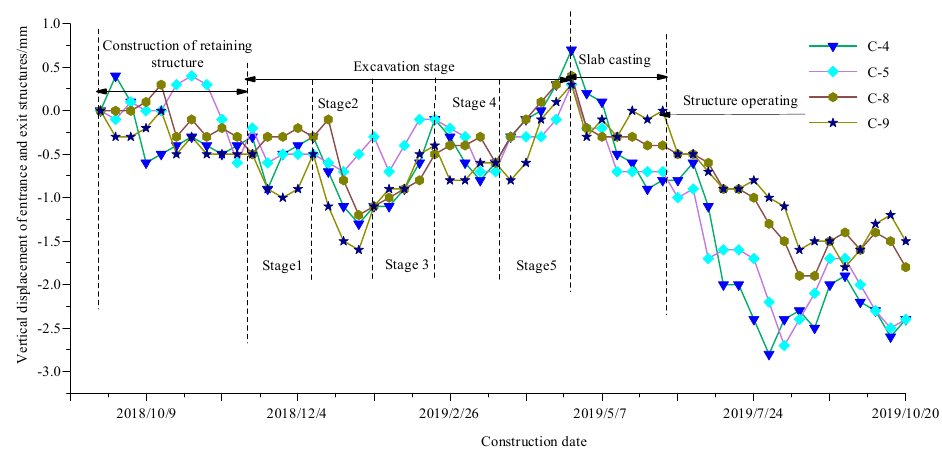
Figure 11. Vertical displacement time − history curve of entrance and exit structures. The measured data of CH-1, CH-2, CH-3 and CH-4 at the horizontal deformation monitoring points at the entrance and exit are selected for analysis, as shown in Figure 12. The horizontal displacement deformation trend of the entrance and exit gradually increases, which is consistent with the horizontal displacement deformation trend of the station, but the growth rate is more obvious than that of the station. The maximum horizontal displacement is 2.8 mm, which is 1.7 times the maximum horizontal displacement of the station. The horizontal displacement trend of each measuring point is biased toward the inside of the foundation pit.